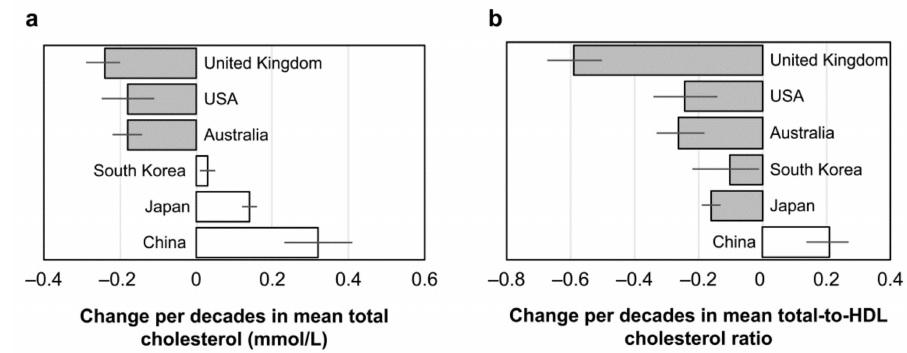
Figure 3. Change per decade since ~1980 in mean total-cholesterol level ( a ) and mean total-to-HDL-cholesterol ratio ( b ) by male aged 40–59 years. Values are means with 95% confidence intervals. Similar but more clear changes are observed in females. Extracted data from reference